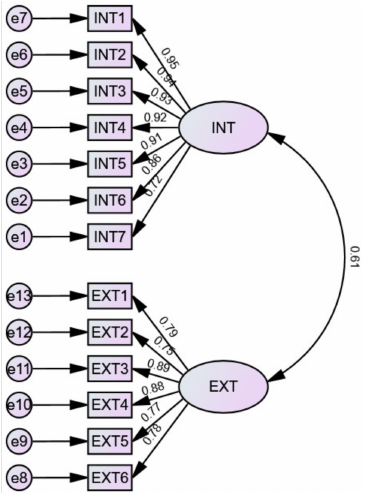
Figure 3. Model 2 path diagram.